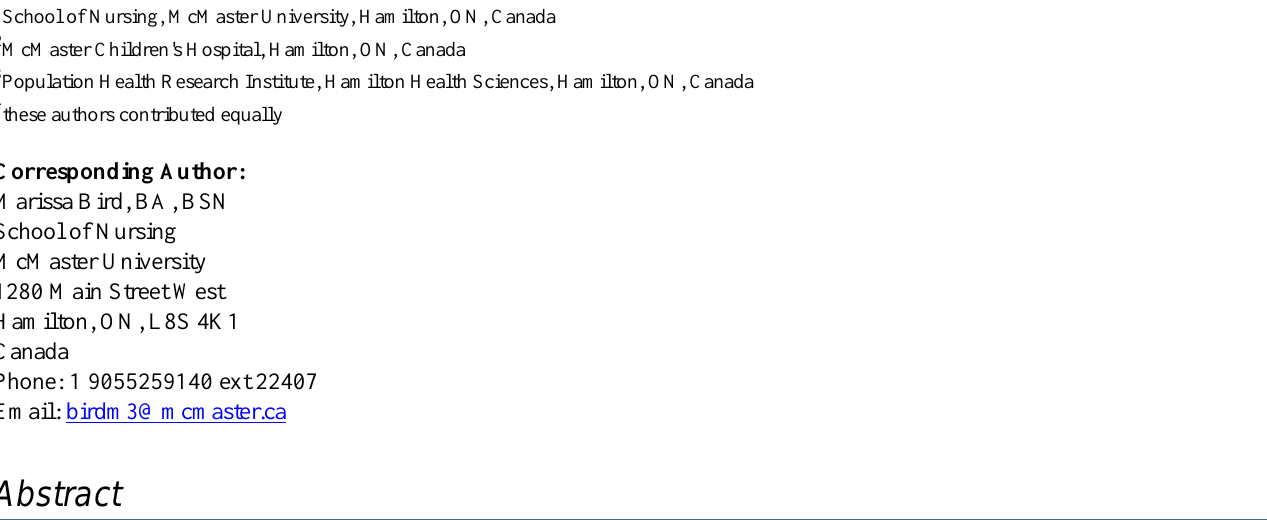
pediatrics; scoping review; digital health; children with special health care needs; asthma; congenital heart disease; palliative care;